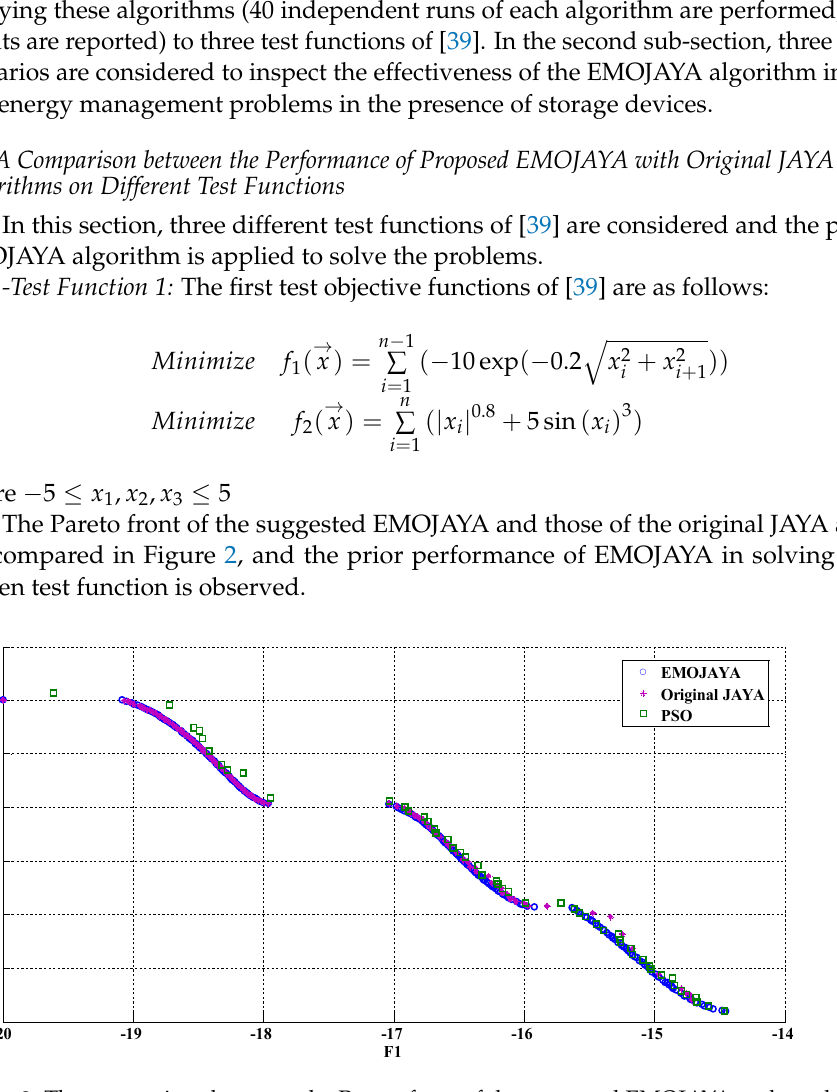
Figure 2. The comparison between the Pareto front of the proposed EMOJAYA and results of JAYA and PSO (Test Function 1).